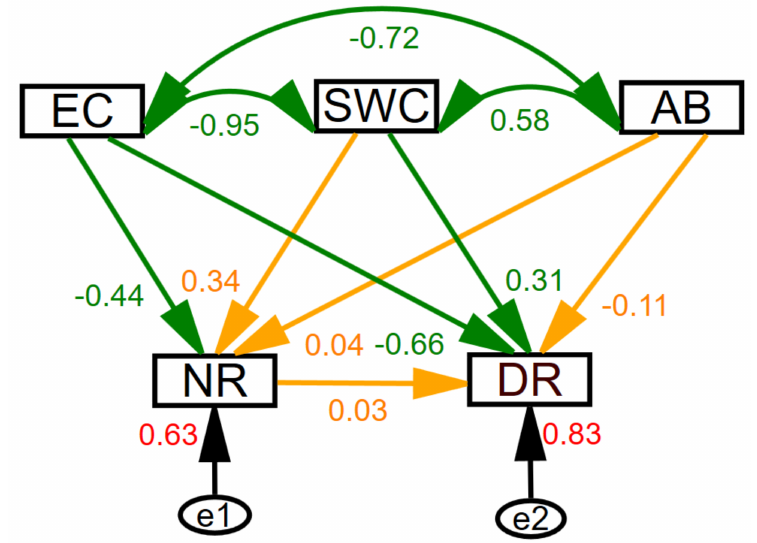
Figure 5. Structural equation model (SEM) revealing influences of main environmental factors (soil electrical conductivity (EC), soil water content (SWC), aboveground biomass (AB)) on soil nitrification rates (NR) and denitrification rates (DR). Green arrows indicate significant ( P < 0.05) and orange arrows indicate insignificant ( P > 0.05) relationships. Numbers beside the arrows are standardized coe ffi cients. The proportion of variation explained by the model is indicated by red numbers near